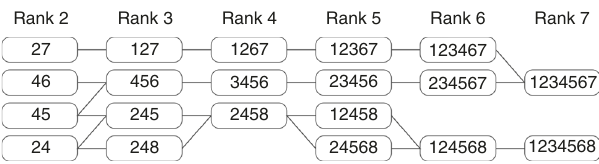
Fig. 7 Potential bundling routes in A/Panama-infected A549 cells. The most abundant MSCs are those represented in Fig. 4 ( ‘ All Cells ’ ). Joining lines were drawn if two MSCs of adjacent ranks with a speci fi c composition of segments could be connected to the next through the addition of a single segment. The numbers in the boxes correspond to segments S1 –